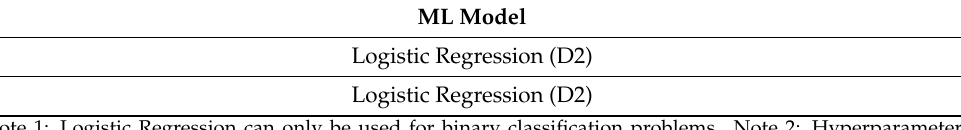
Table A3. Logistic Regression.